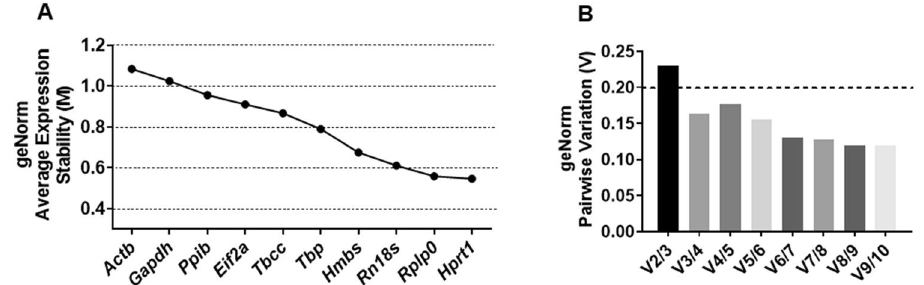
Figure 2. Gene expression stability and optimal number of reference genes required for accurate normalization using GeNorm. ( A ) The geNorm algorithm ranks the reference genes by stepwise exclusion of the least stable reference genes, with the least stable reference gene having the highest M value and vice versa. ( B ) Pairwise variation (Vn/Vn + 1) analysis by geNorm determines the optimal number of genes required for accurate normalization. geNorm V < 0.20 is considered acceptable. The value V3/4 is 0.16, which indicates that the inclusion of the fourth reference gene is not needed for accurate normalization.